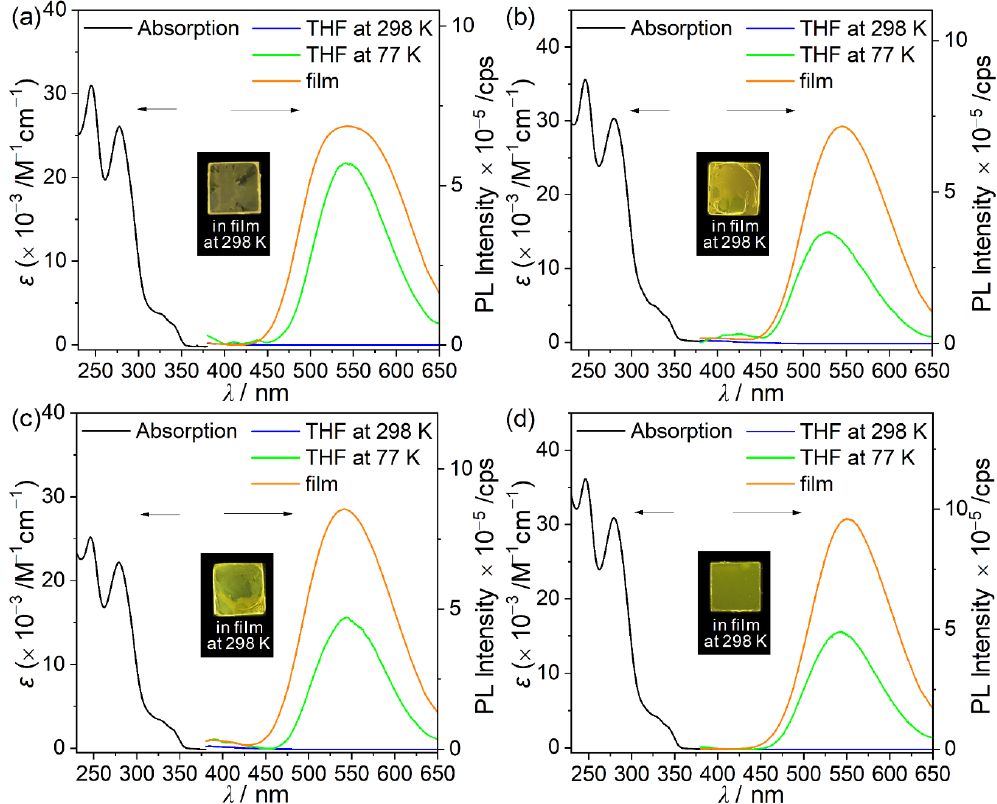
Figure 3. UV-vis absorption (left) and PL spectra (right) of ( a ) 1F (λ ex = 329 nm), ( b ) 2P (λ ex = 328 nm), ( c ) 3M (λ ex = 330 nm), and ( d ) 4T (λ ex = 333 nm). Black line: absorption spectra in THF (30 μM), blue line: PL spectra in THF (30 μM) at 298 K, green line: PL spectra in THF (30 μM) at 77 K, and orange line: PL spectra in film (5 wt% doped in PMMA) at 298 K. Insets: emission color in the film state under irradiation by a hand-held UV lamp (λ ex = 365 nm). Table 1. Photophysical data for 9-phenyl-9 H -carbazole-based o -carboranyl compounds.